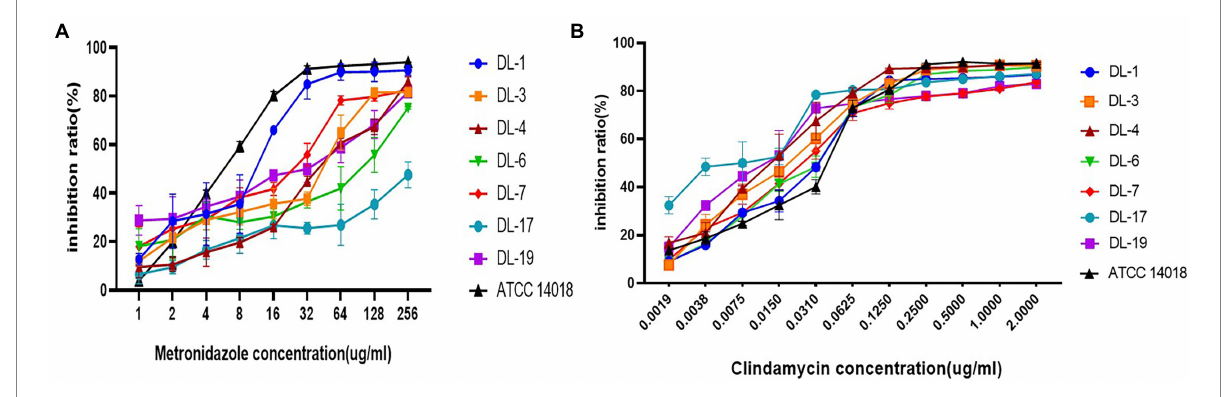
FIGURE 4 Biofilm inhibition rates of G. vaginalis in response to metronidazole and clindamycin. (A) Inhibition rates of metronidazole on the formation of biofilm by various samples. (B) Inhibition rates of